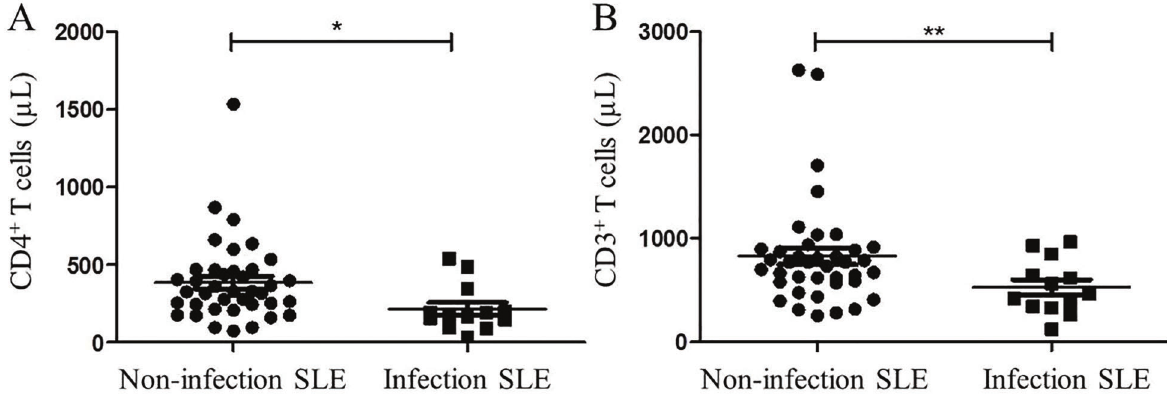
Figure 1. Distribution of ( A ) CD4 + and ( B ) CD3 + T cell numbers between the two groups of systemic lupus erythematosus (SLE) patients. *P o 0.05, **P=0.05 (Student ’ s t -test).